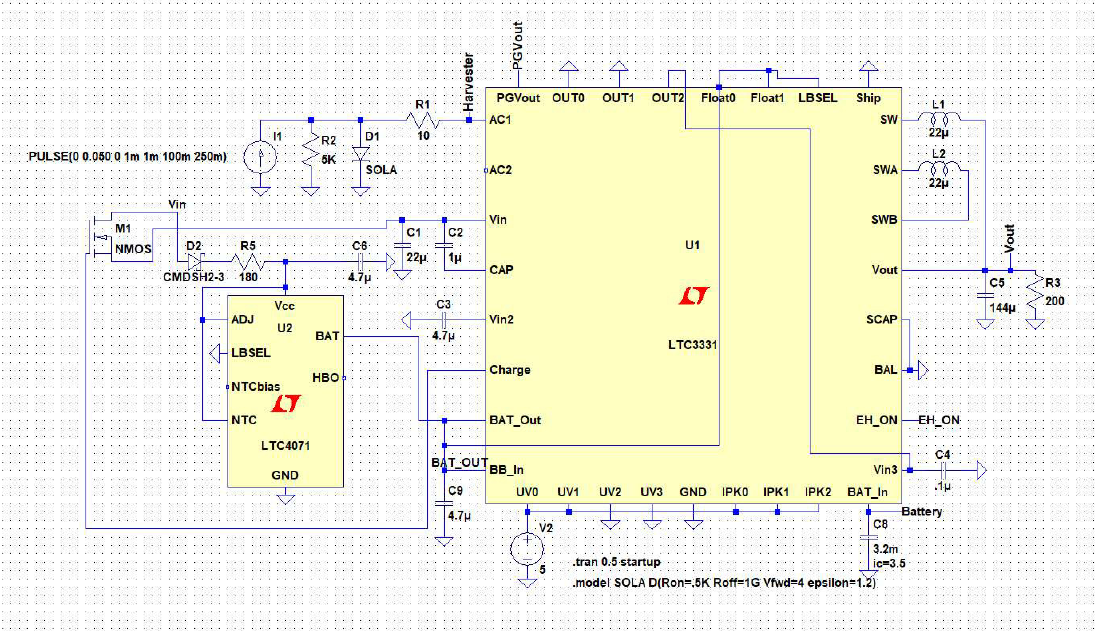
Figure 8. Schematic from the simulation of the combination of LTC3331 with the LTC4071 to increase the charging current for the rechargeable